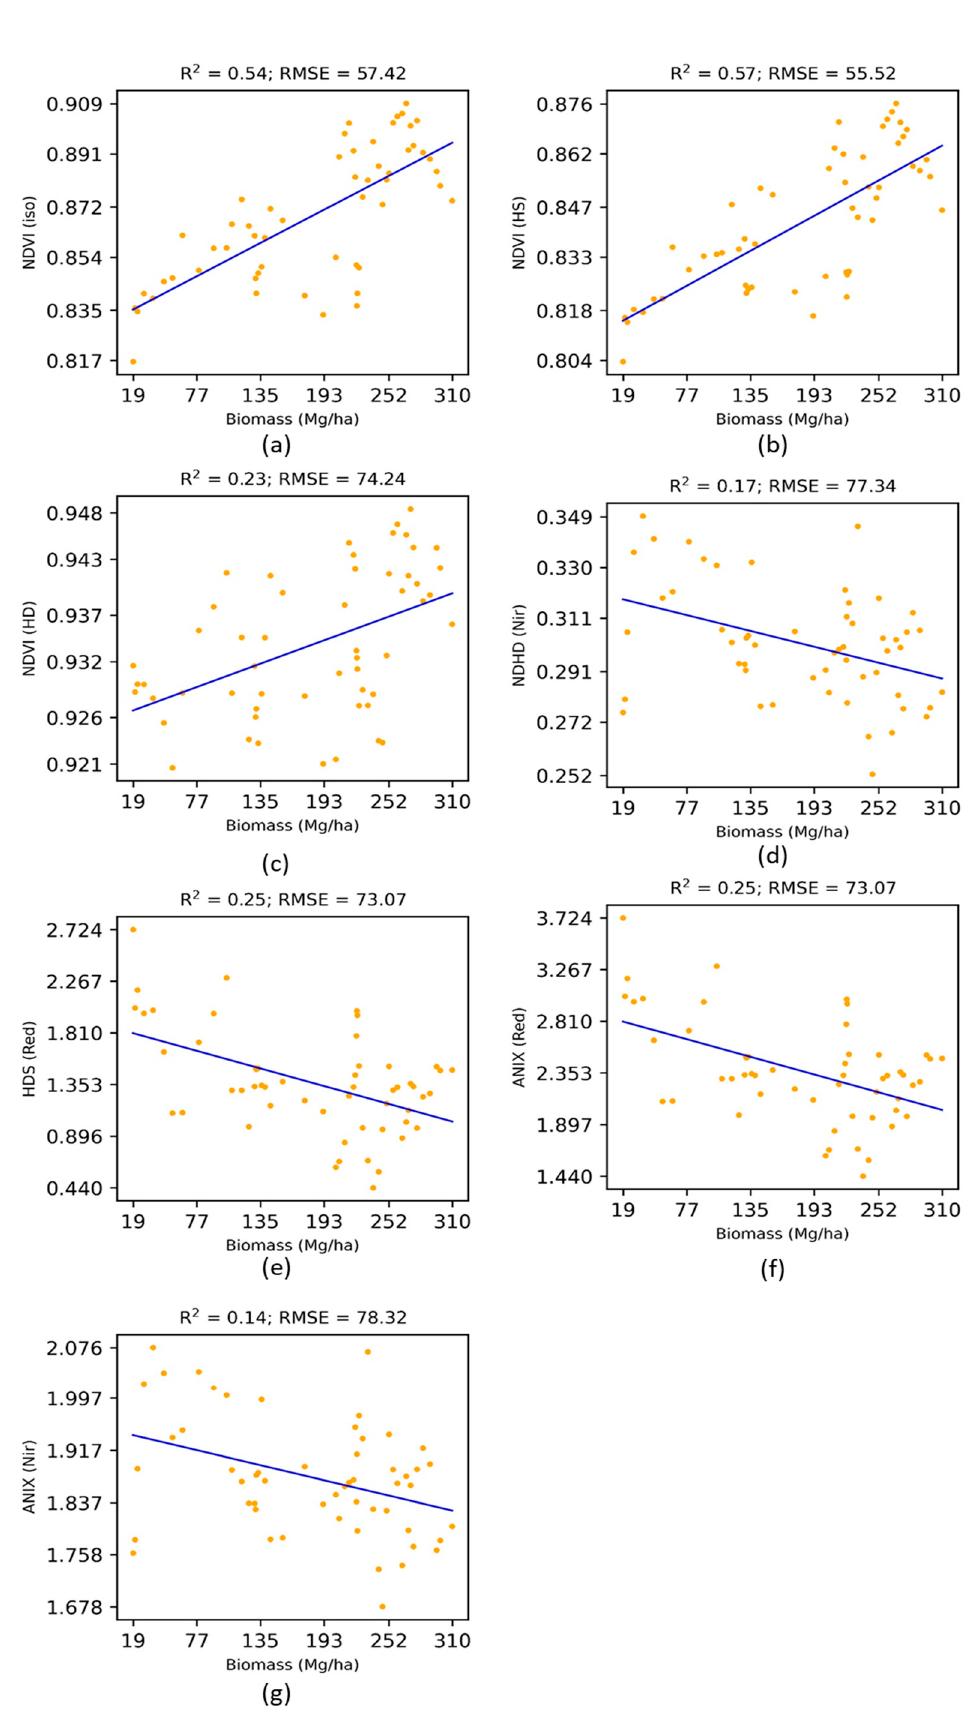
Figure 2. Performance of existing multi-angular vegetation indices for the estimation of above-ground